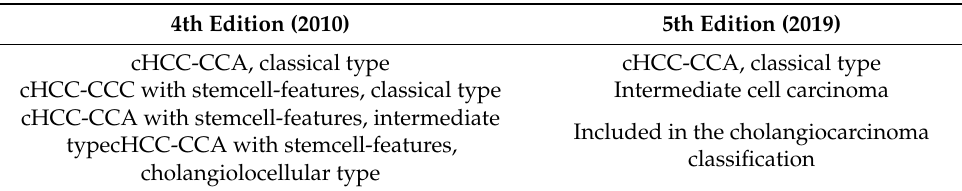
Table 1. Evolution of the World Health Organization (WHO) classification of combined